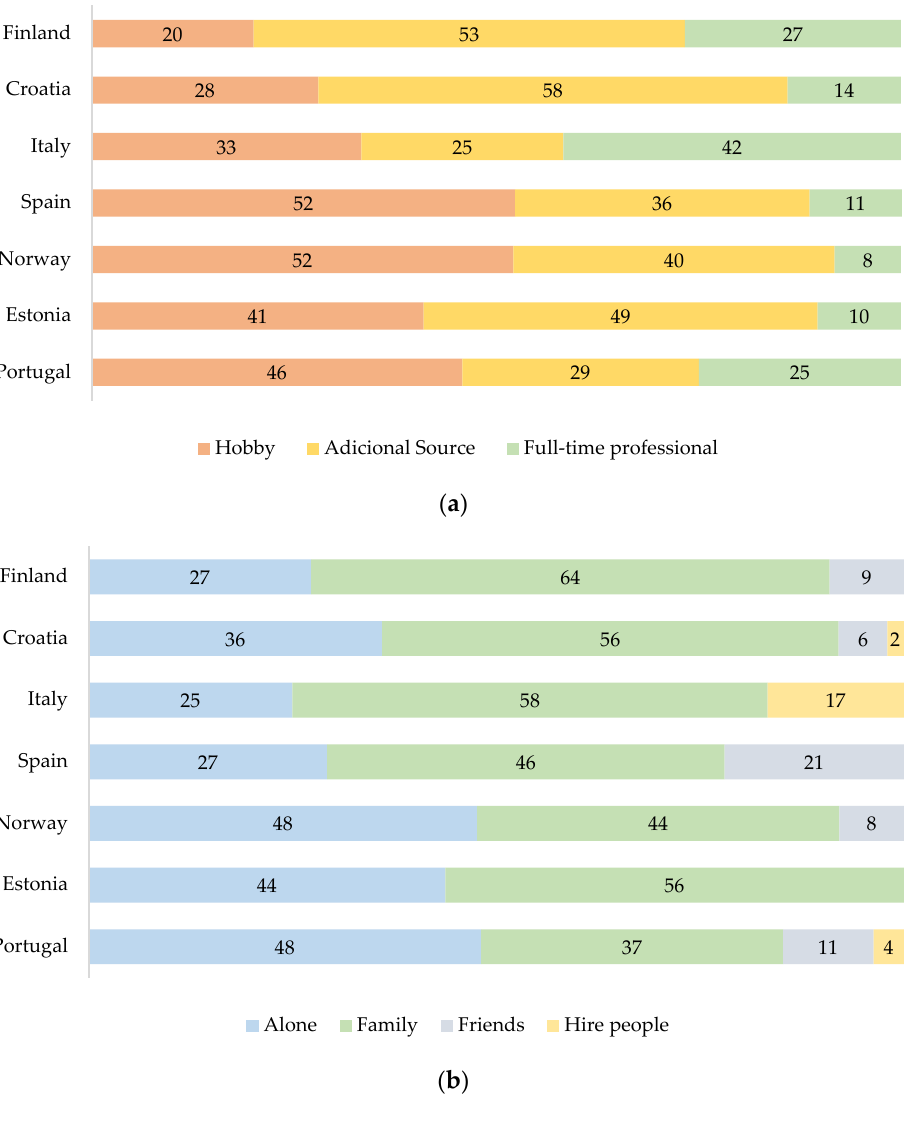
Figure 5. Relative distribution of the beekeeping activity relevance ( a ) and people who work in beekeeping by country ( b ) (%). Table 3. Relevant products of beekeeping activities by country (Results presented as number of